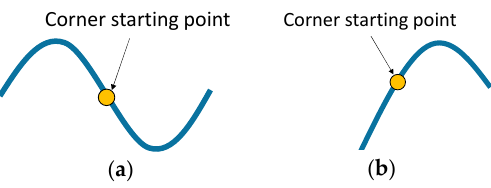
Figure 1. ( a ) The corner starting point where corners were continuous; ( b ) The corner starting point in cases where corners were not continuous.